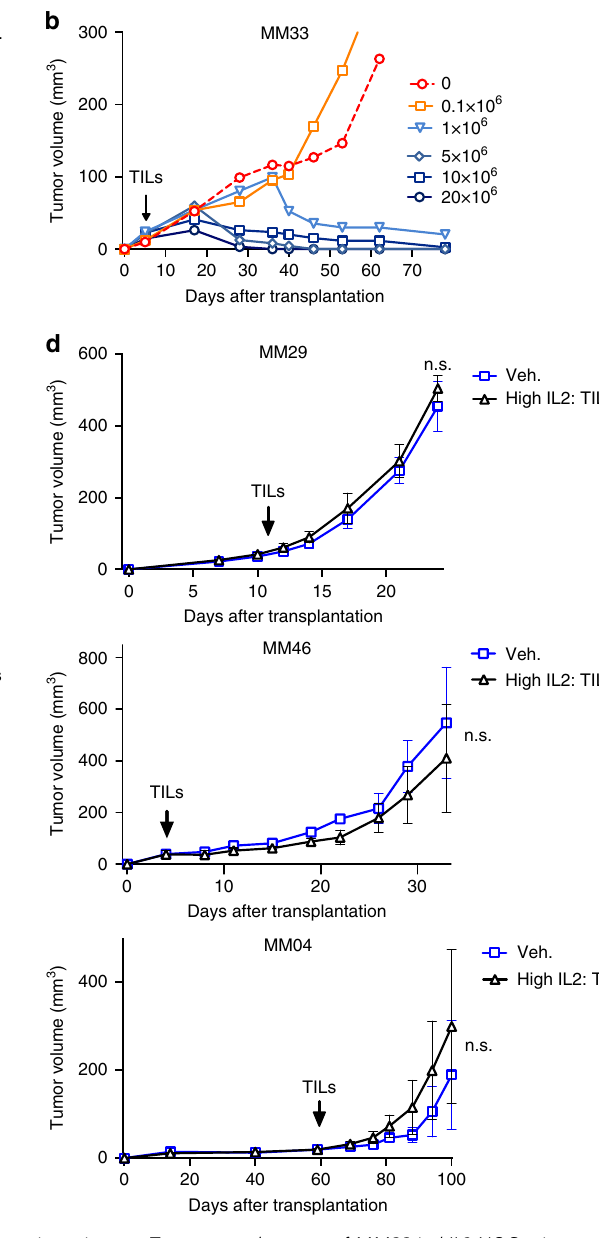
Fig. 4 ACT in mice with high levels of plasma hIL-2 correlates with responses in patients. a Tumor growth curves of MM33 in hIL2 -NOG mice expressing high ( > 2 ng/ml) or low levels of hIL-2 ( < 1.5 ng/ml), treated either with PBS or TILs in the presence or absence of pembrolizumab. b Dose titration response of MM33 to different amounts of injected TILs (from 0.1×10 6 to 20×10 6 TILs) in hIL2 -NOG mice with high levels of hIL2. c , d Tumor growth curves of cells from three responders in the clinic ( c : MM11, MM24 and MM05) and from two non-responders ( d : MM04, MM46 and MM29) in hIL2 - NOG mice with high levels of hIL-2 treated either with PBS or TILs. Data are caliper measurements (MM33/MM24/MM05/MM04, n = 4 per group; MM11/MM29/MM46, n = 3 per group). P -values are from multiple t -test (with Sidak corrections) for tumor growth curves. Experiment in a was performed twice, a replicate shown in Supplementary Fig. 5. Experiments in b , c were performed once except for MM24 where a replicate experiment is shown in Supplementary Fig.